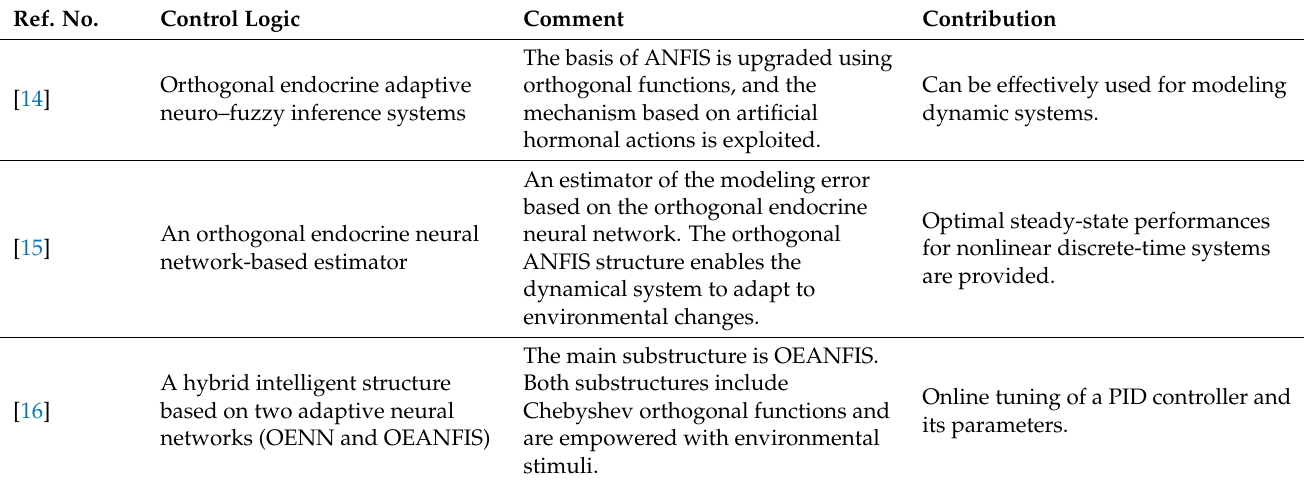
Table 1. A review of the authors’ research concerning OENNs. Ref.